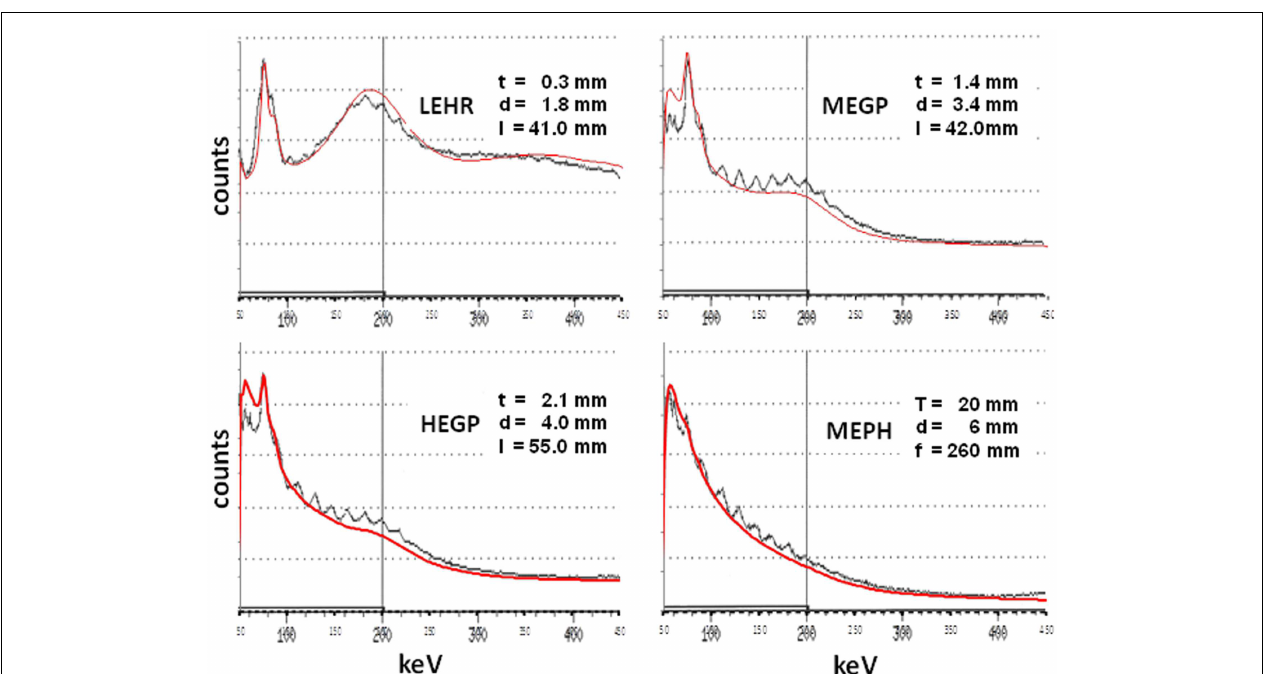
septal thickness, d the hole diameter, l the hole length. For MEPH, T is the front housing thickness, and f the focal length. Note the absence of lead fluorescence peak for the MEPH collimator.The oscillations observed in the acquisitions from 100 to 220keV (17keV-period) were not